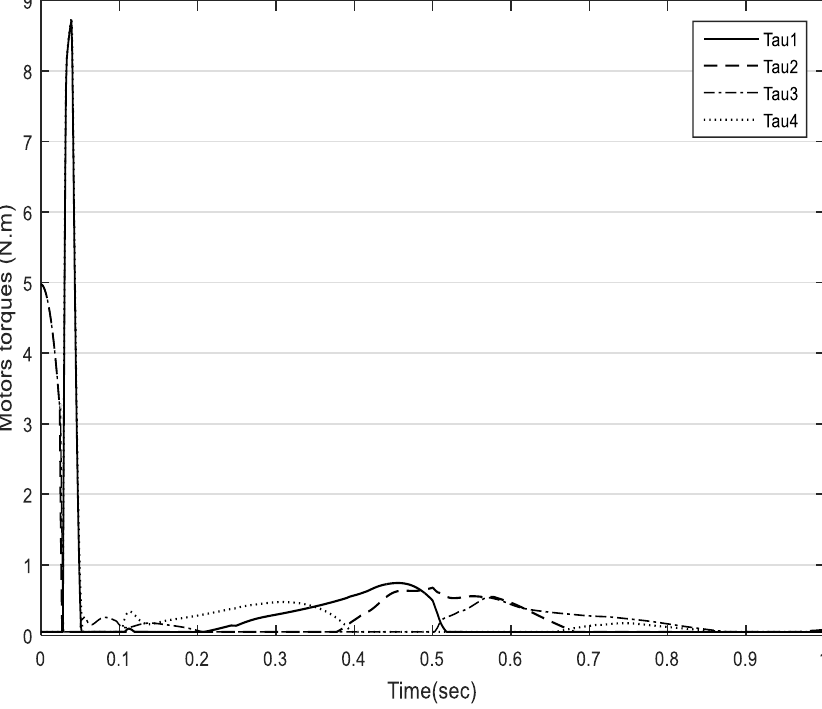
Figure 7. Motors torques produced by NGPC for T = 0.01 s.